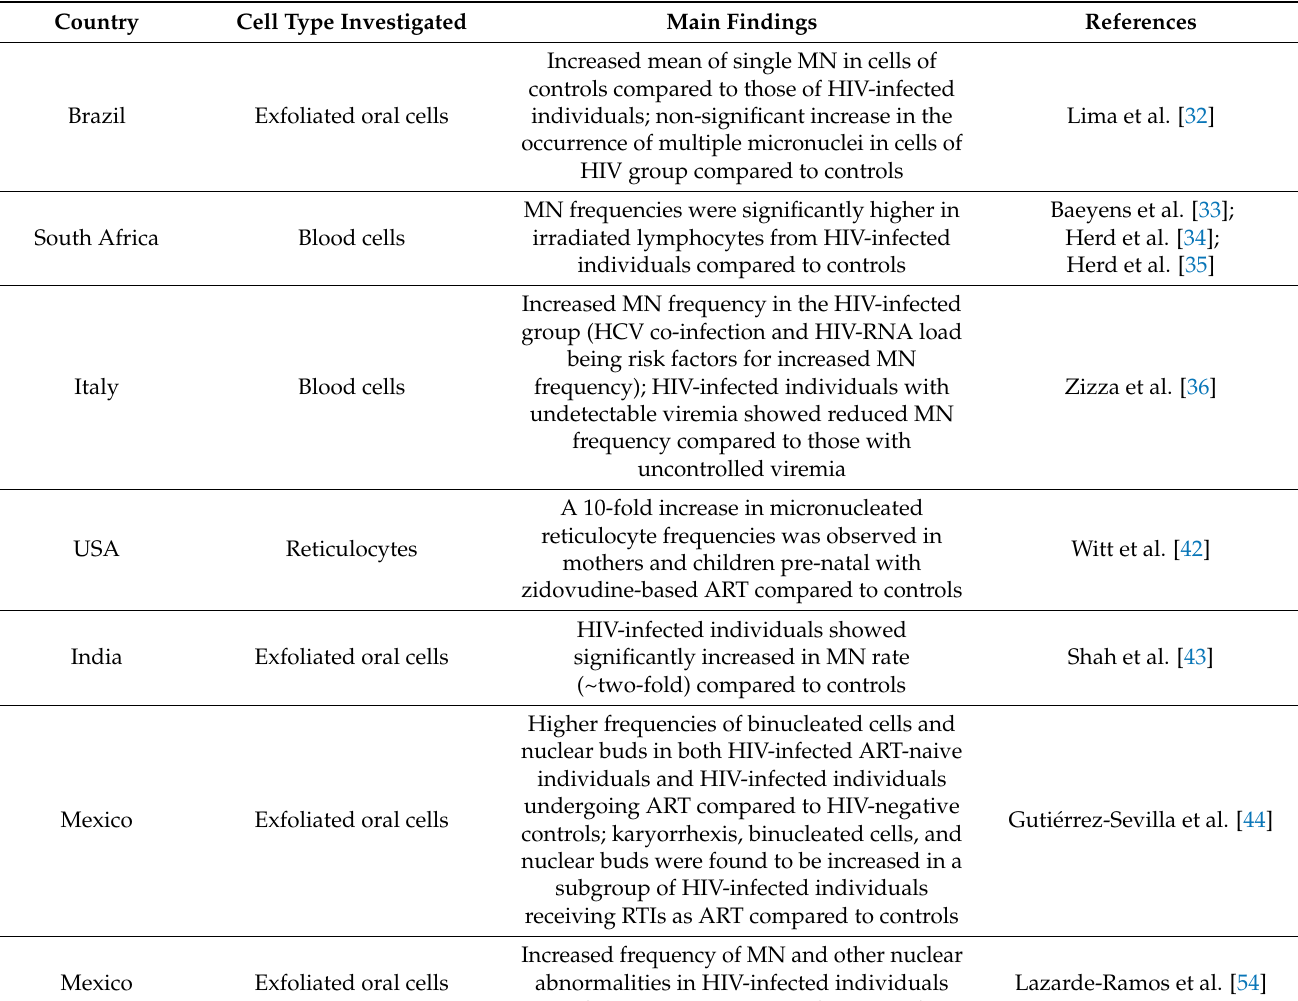
Table 1. Summary of the impacts of HIV infection and treatment on chromosomal integrity based on studies with